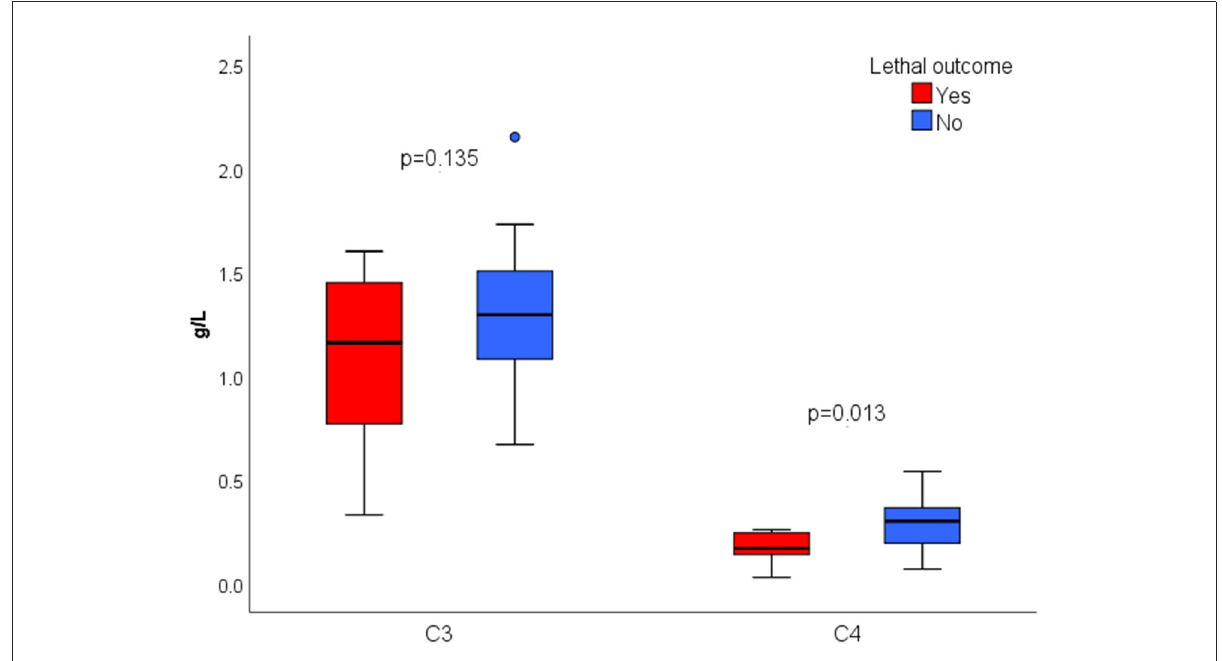
FIGURE2 Serum C3 and C4 concentration according to the outcome.